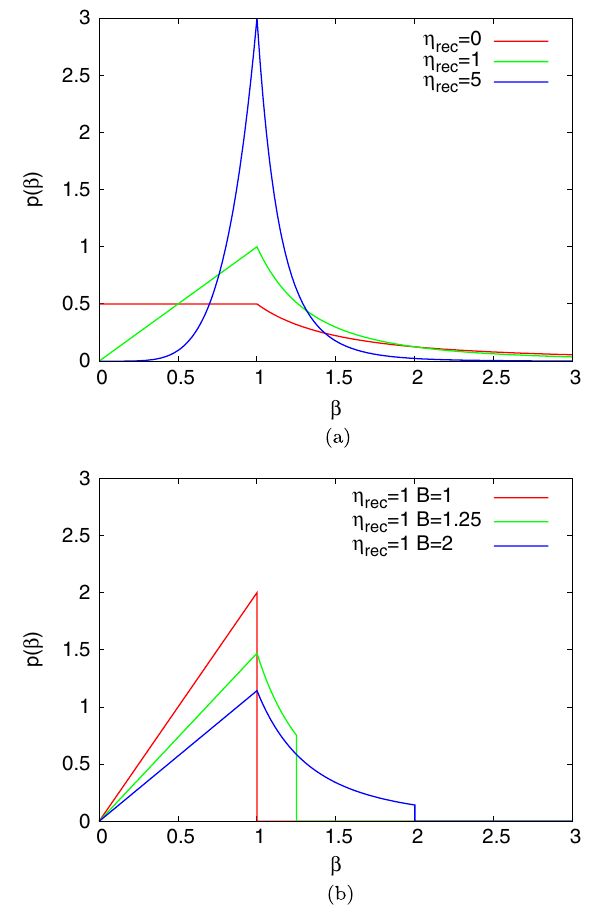
FIG. 29. Probability density functions used in simulated binary crossover recombination: (a) when the independent variable domain is unconstrained for three values of (cid:7) (b) when the independent variable domain is restricted to x L (cid:2) x